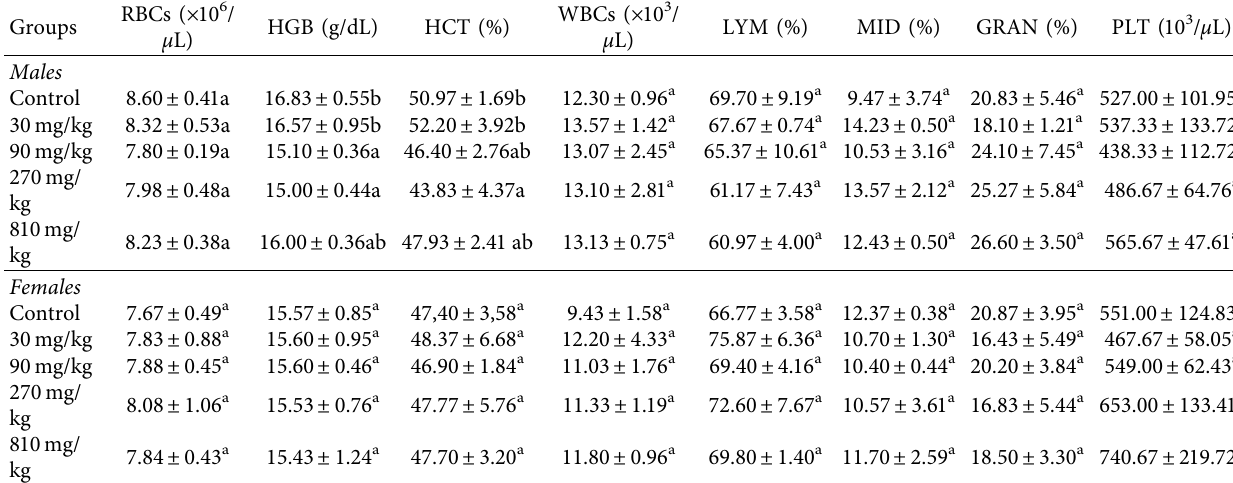
Table 4: Effect of aqueous extract of T. grandis leaves on hematological parameters of animals.